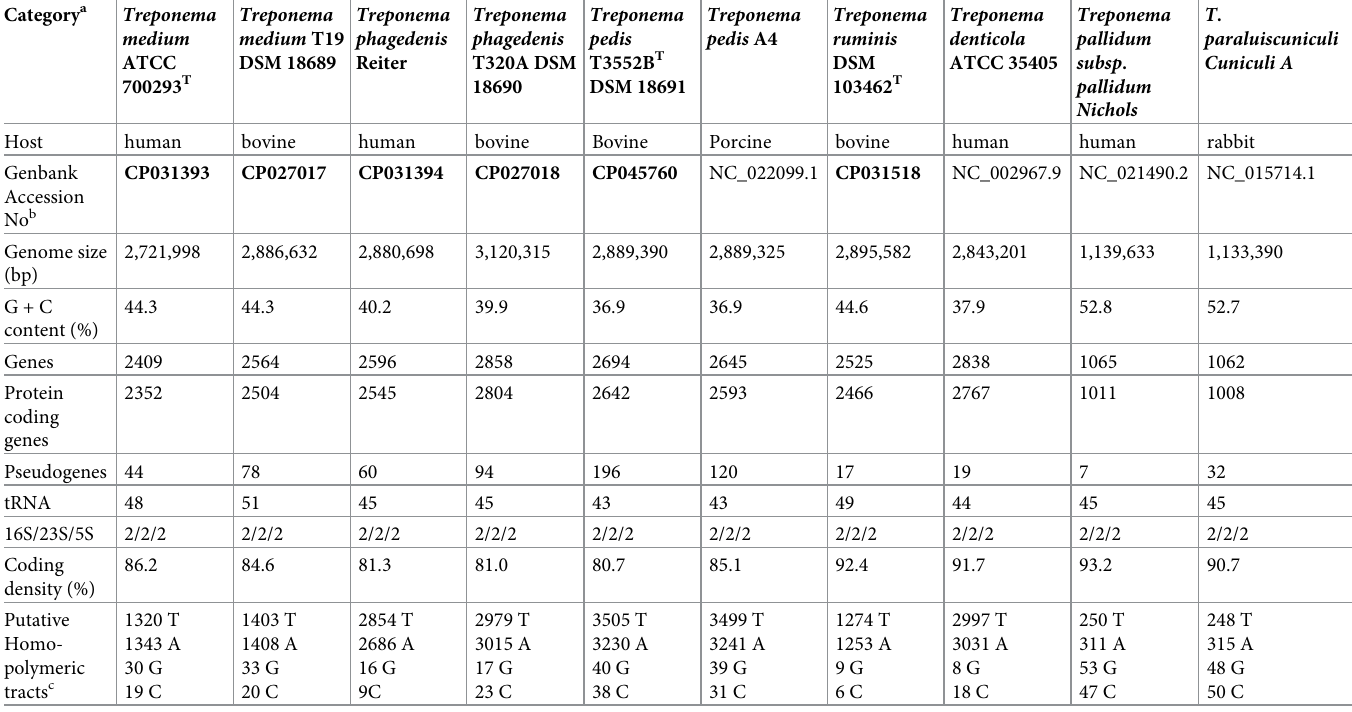
Table 1. General features of human and bovine representatives of T . medium and T . phagedenis , bovine T . pedis , and bovine T . ruminis compared (six new complete genomes) with human T . denticola , porcine T . pedis and human and rabbit syphilis treponemes. Category